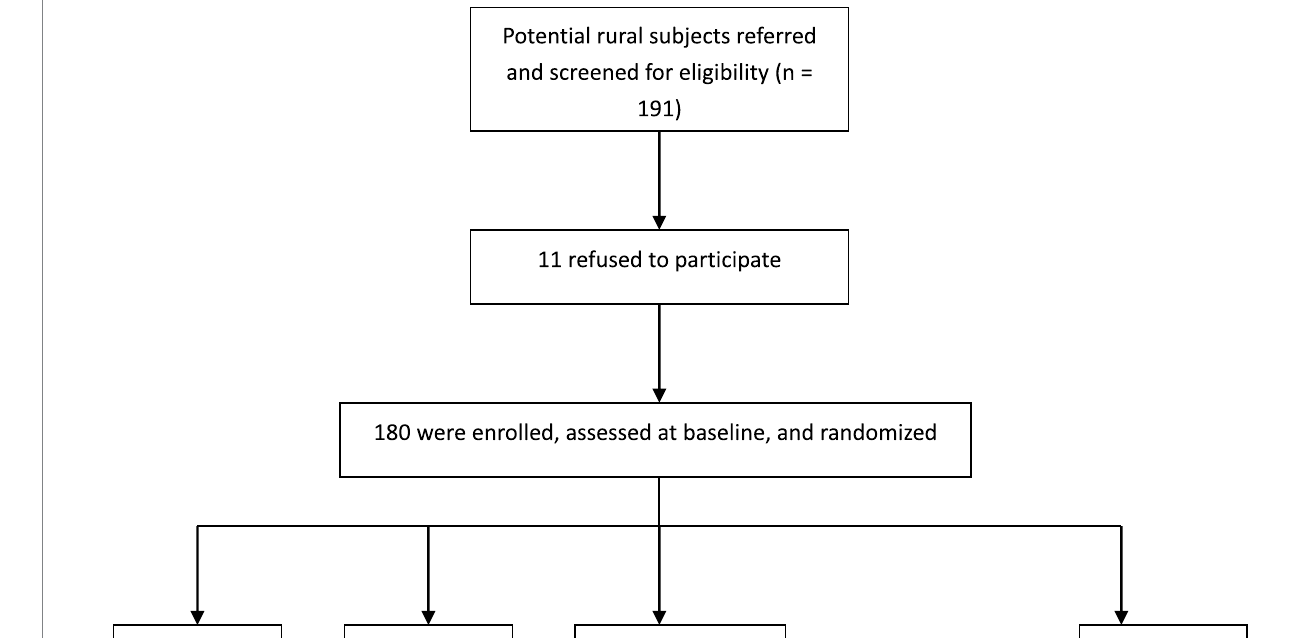
FIGURE 1 Study procedure. Cog, cognitive intervention; PMR, progressive muscle